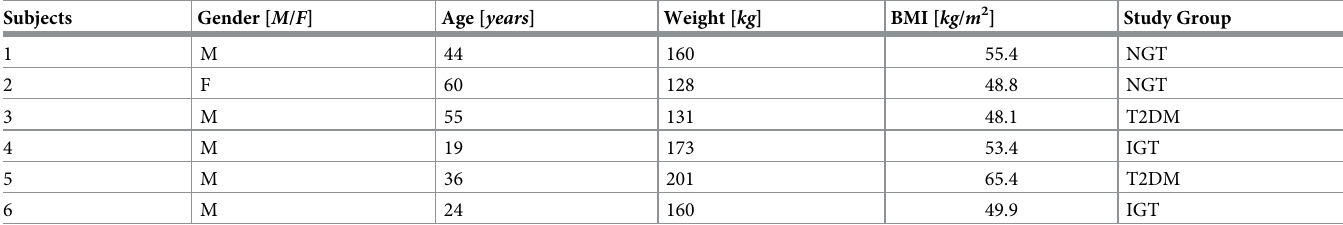
Table 1. Anthropometric characteristics of the studied